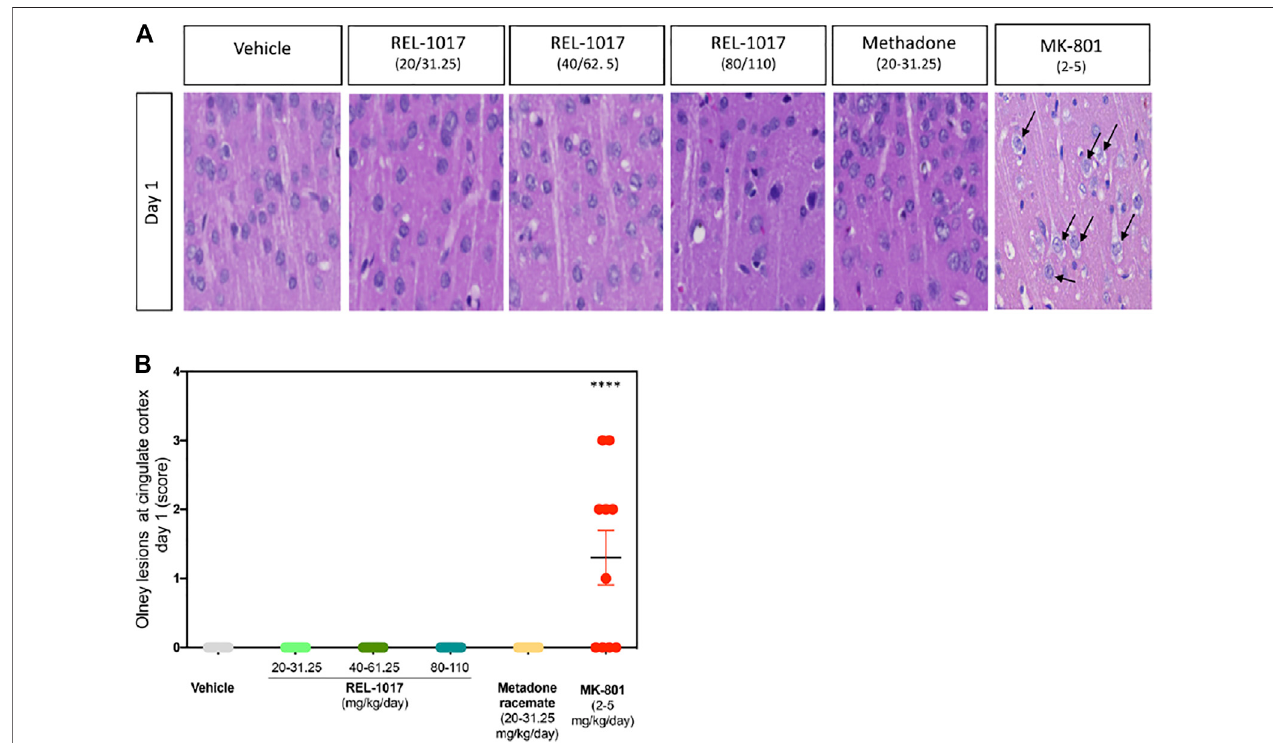
FIGURE 2 | Acute administration of REL-1017 did not cause Olney lesions in the brain cingulate cortex. (A) histological examination of the cingulate cortex, one of the brain regions which are most vulnerable to the neurotoxic effect of acute NMDA receptor antagonism. Black arrow marks indicate the presence of the neuronal vacuolations, which are the microscopic features of Olney ’ s lesions, in the brains of animals treated with MK-801 (positive control). (B) To statistically compare differences between treatment groups, we have quanti fi ed the number and scored a grade of Olney ’ s lesion severity. This analysis con fi rmed that oral gavage administration of REL-1017 in all tested doses to both male and female prague-Dawley rats did not produce Olney ’ s lesions. Compared to REL-1017, the effect of MK- 801 on cortical neurons was statistically signi fi cantly different ( p < 0.0001). Also, the oral administration of methadone racemate to both male and female Sprague- Dawley rats did not produce Olney ’ s